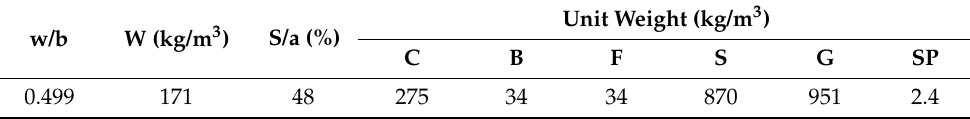
Table 2. Concrete mix ratio.